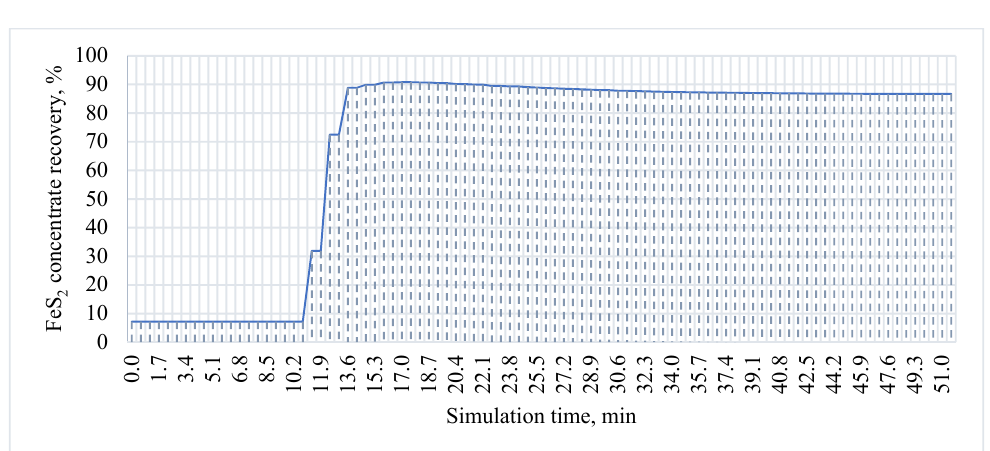
Figure 7. FeS 2 concentrate recovery.